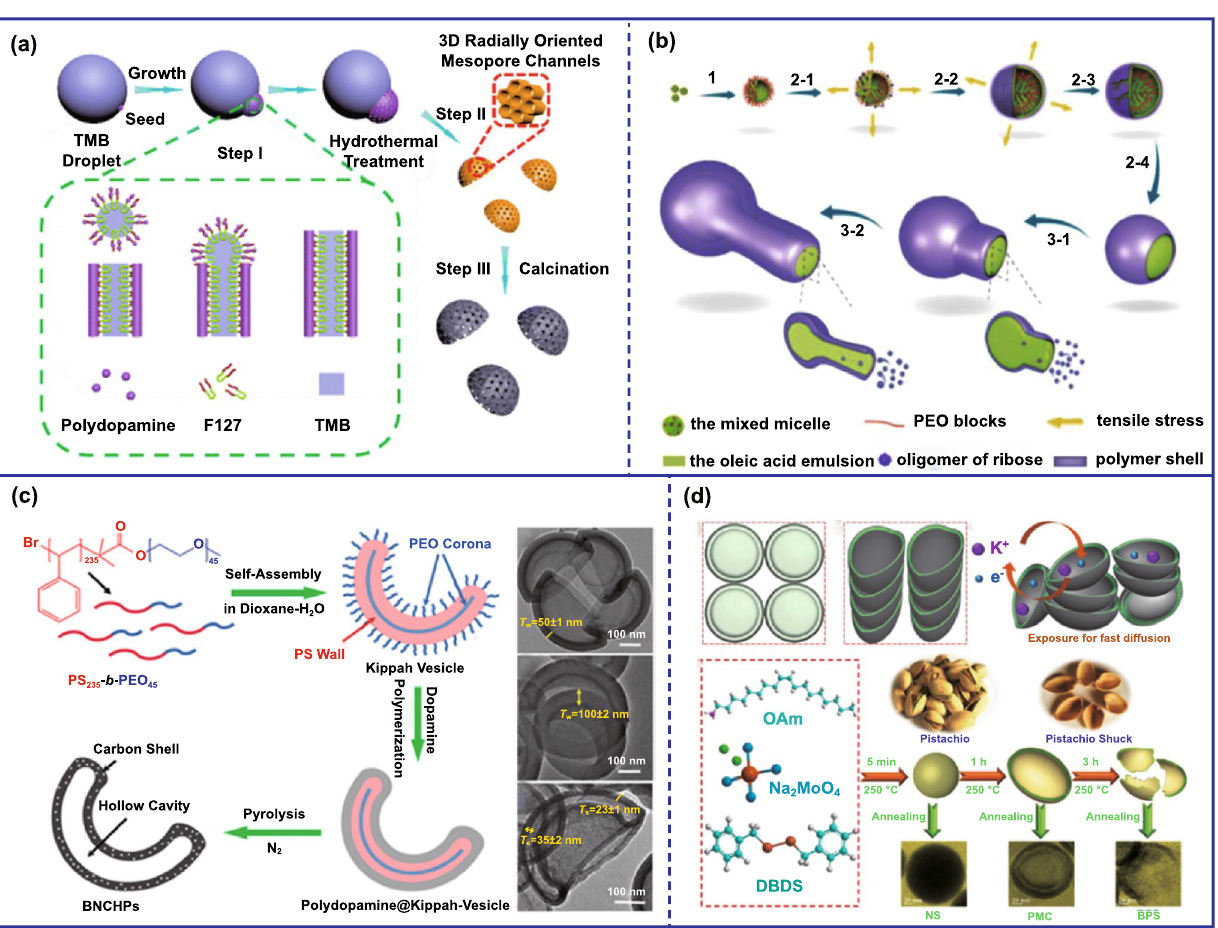
Fig. 4 a Fabrication of asymmetric mesoporous carbon nanoparticles through interfacial assistance. Reproduced with permission from Ref. [37]. Copyright 2016, American Chemical Society. b Asymmetric flask-like carbon nanoparticles were fabricated using the high-temperature hydrothermal approach at the emulsion interface. Reproduced with permission from Ref. [40]. Copyright 2017, American Chemical Society. c Fabrication of bowl-like structures through the asymmetric template. Reproduced with permission from Ref. [21]. Copyright 2016, Royal Society of Chemistry. d Fabrication of asymmetric carbon through other method. Reproduced with permission from Ref. [43]. Copyright